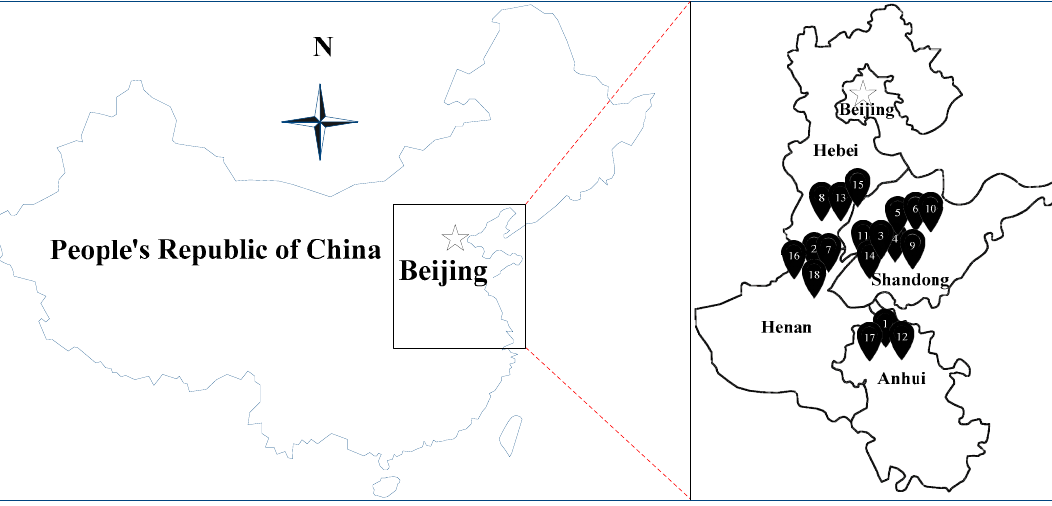
Figure 2. Location of the selected water inrush cases in North China.